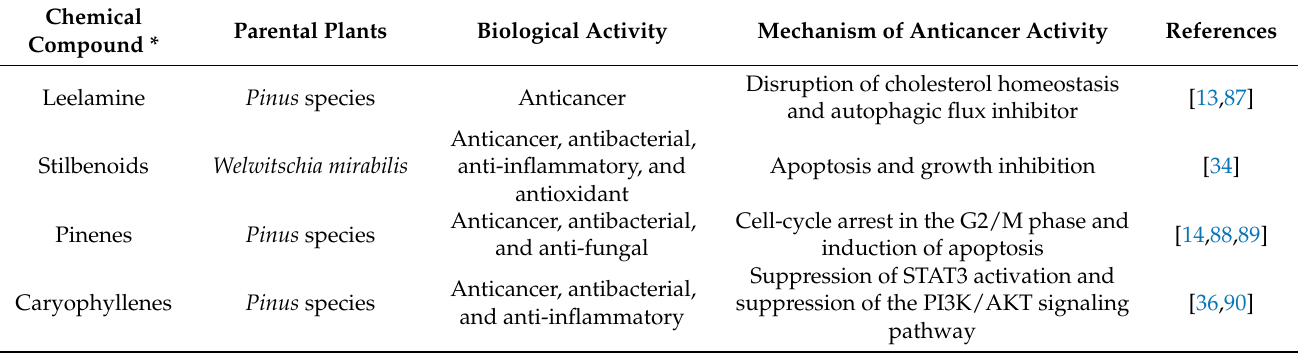
Table 2. Gymnosperm-derived chemical compounds with therapeutic